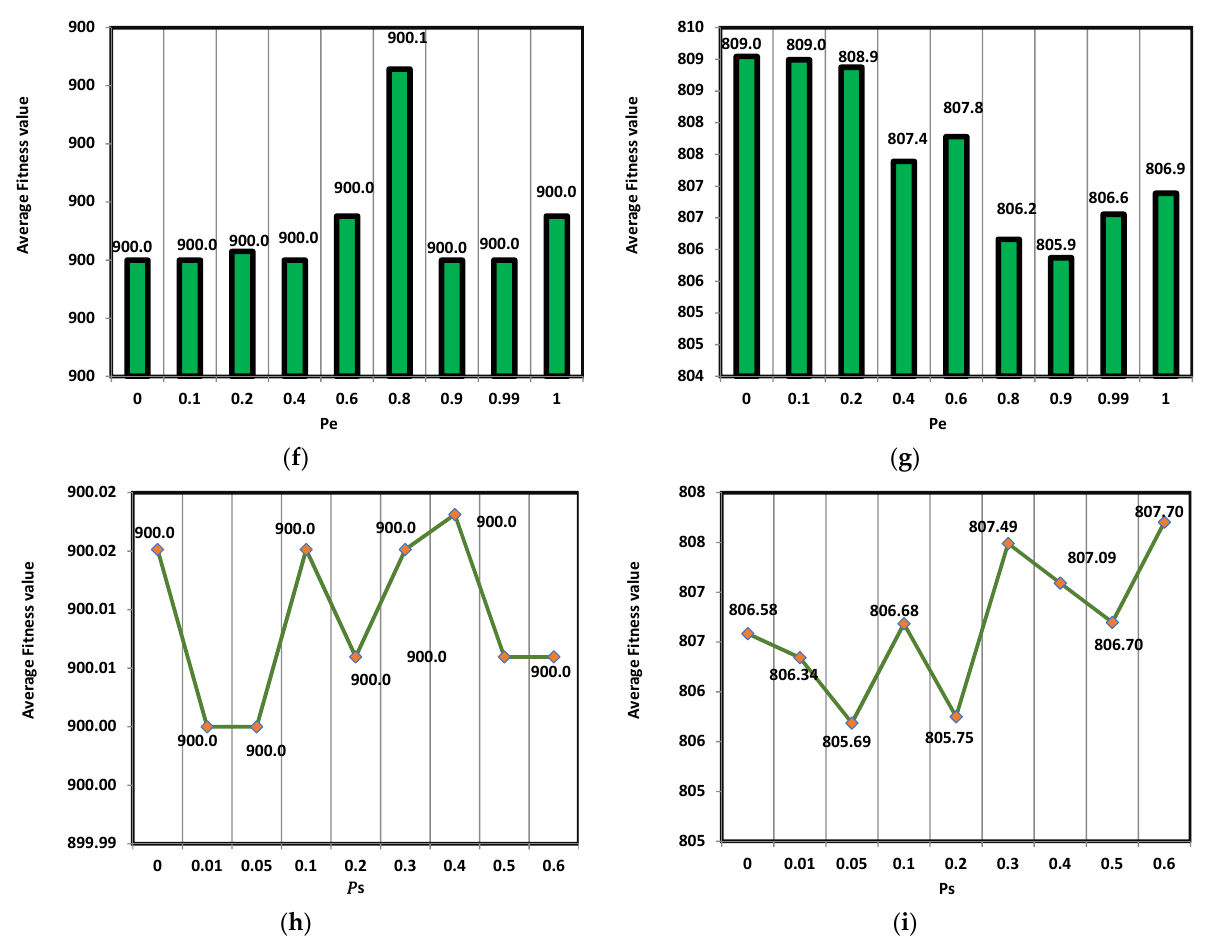
Figure 8. Sensitivity analysis of LSO. ( a ) Tuning the parameter P h over F58. ( b ) Tuning the parameter P h over F57. ( c ) Tuning the parameter 𝛽 over F58. ( d ) Tuning the parameter 𝛽 over F57. ( e ) Tuning the parameter 𝛽 over F58 in terms of convergence speed. ( f ) Tuning the parameter P e over F58. ( g ) Tuning the parameter P e over F57. ( h ) Adjusting the parameter P s over F58. ( i ) Adjusting the parameter P s over F57.